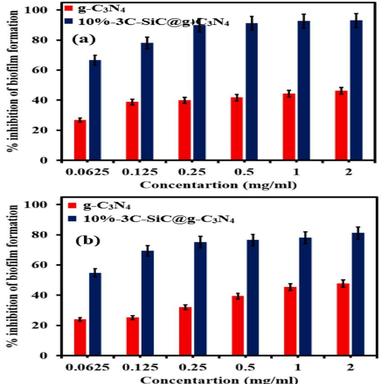
Percentage of inhibition of biofilm formation with pure g-C3N4 and 10%-3C–SiC@g-C3N4 nanocomposite for MDR-PA (a) and MRSA (b).